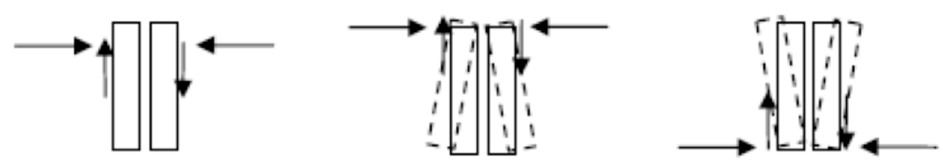
Figure 4. Stresses not producing or producing detachment strains in the cell.